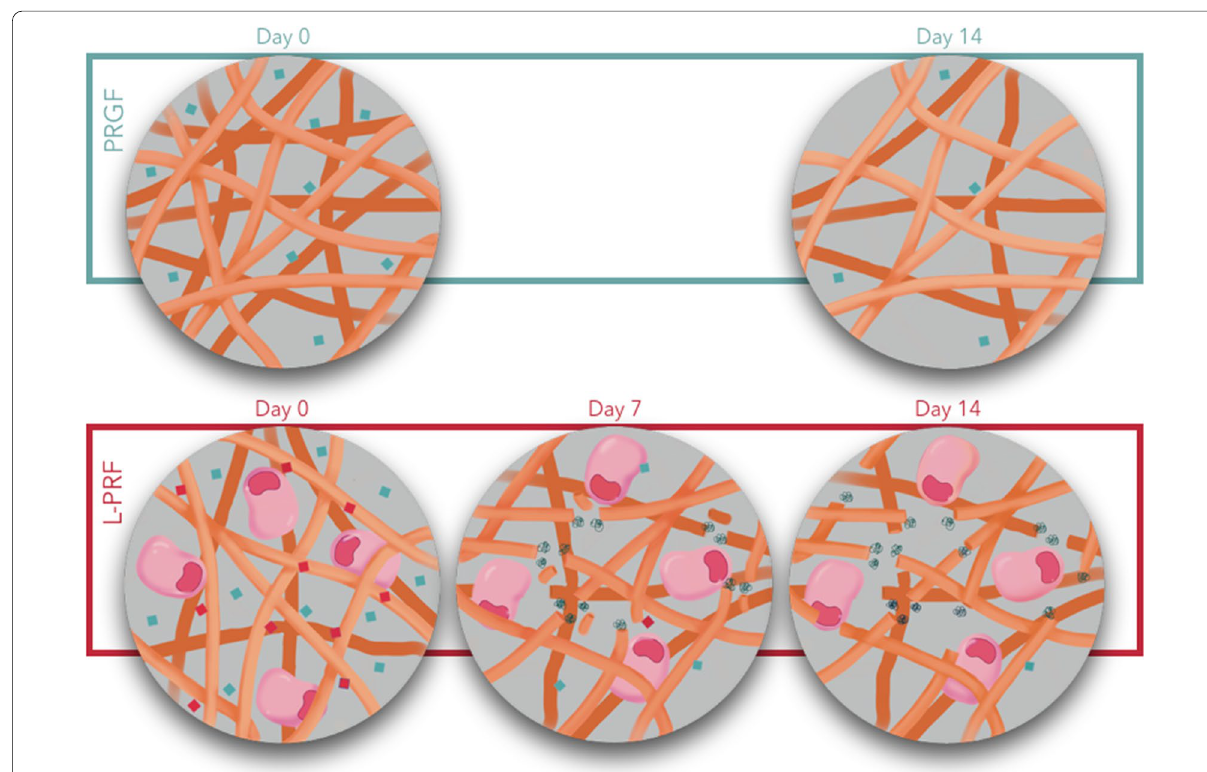
Fig. 5 The presence of leukocytes could explain a faster degradation of the fibrin matrix in L‑PRF and thus a faster release of growth factors. In addition, the degree of cross‑linking of the fibrin mesh could also affect the release